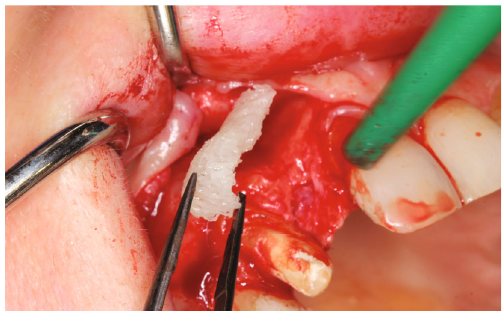
Figure 8: Intraoral view after opening the mucoperiosteal fl ap and inserting the individually CAD/CAM-milled block.